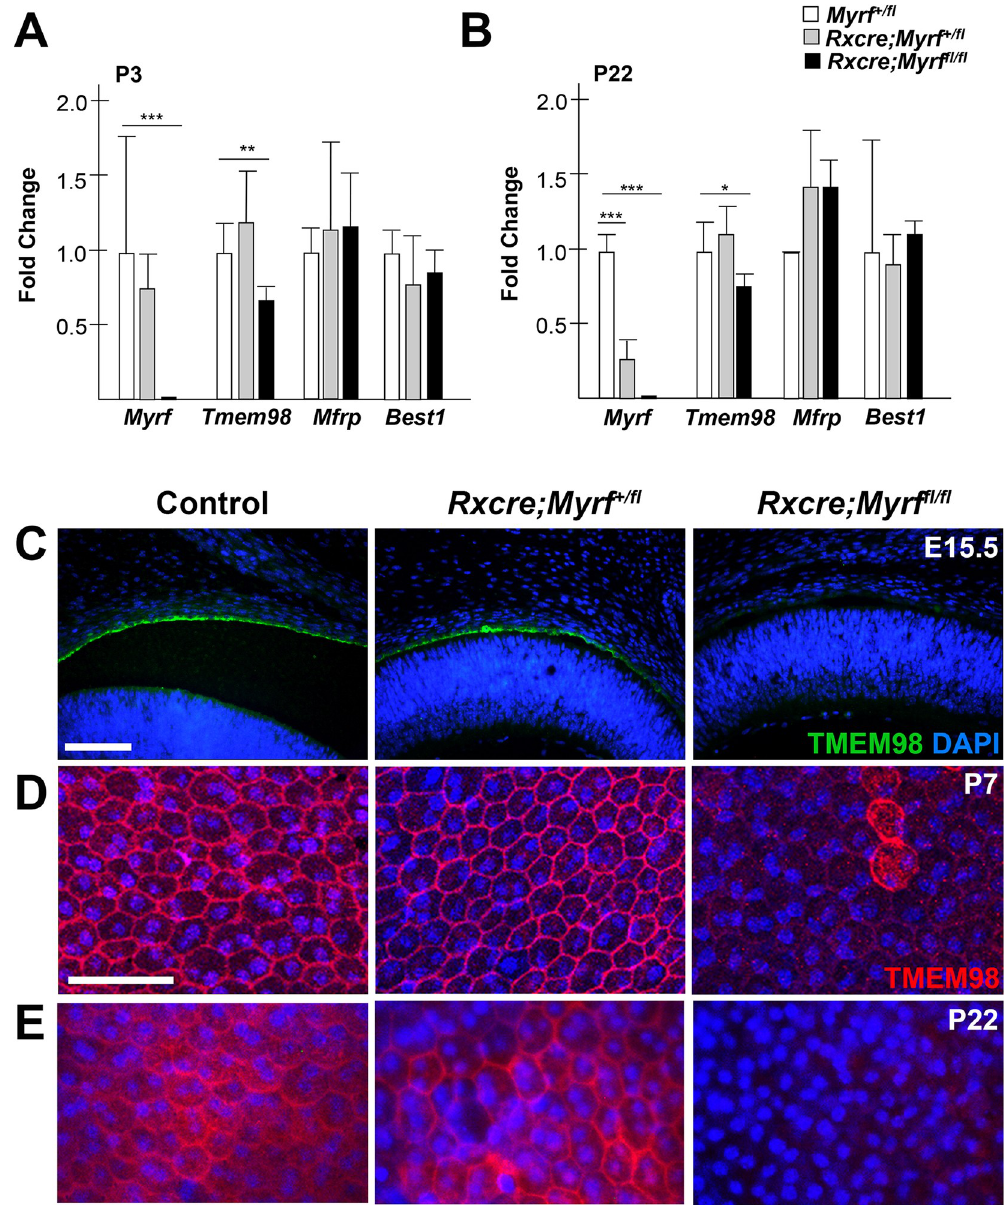
Fig 8. TMEM98 is genetically downstream of MYRF. (A-B) Taqman qRT-PCR analysis of RPE expressed genes important for nanophthalmos ( Myrf , Best1 , Mfrp , Tmem98 ) in Myrf +/fl , RxCre;Myrf +/fl and RxCre;Myrf fl/fl eyes at P3 (A) and P22 (B). There is significantly reduced expression of Tmem98 in RxCre;Myrf fl/fl compared to wild-type, but comparable levels of expression of Mfrp and Best1 . (C) TMEM98 staining in embryonic (E15.5) mouse eyes showing loss of TMEM98 staining in RxCre;Myrf fl/fl compared to controls. (D-E) Mouse RPE flat mounts from P7 (D) and P22 (E) eyes showing decreased TMEM98 staining (red) and altered localization in RxCre;Myrf fl/fl compared to controls. DAPI (blue) is used to counterstain nuclei. ��� , p < 0.001; �� , p < 0.01; � p <